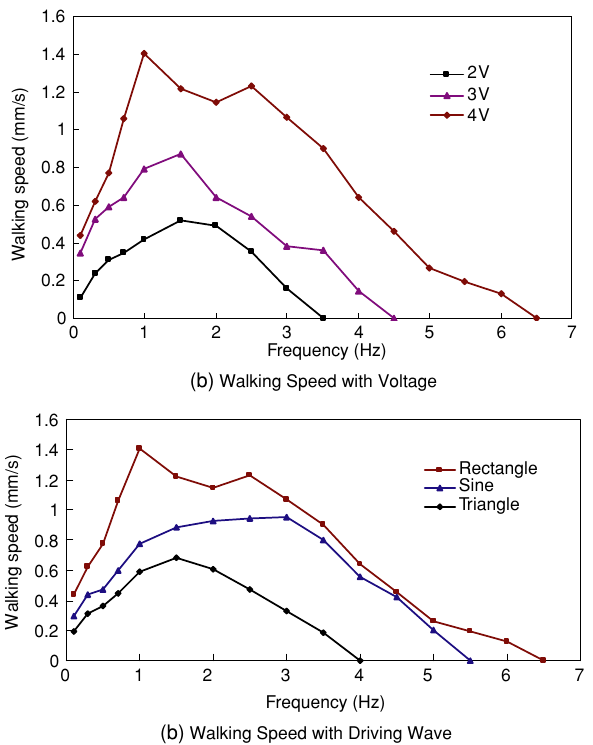
Figure 16 Experimental results of the micro-robot with one degree of freedom. (a) Walking speed with voltage, (b) walking speed with driving wave.